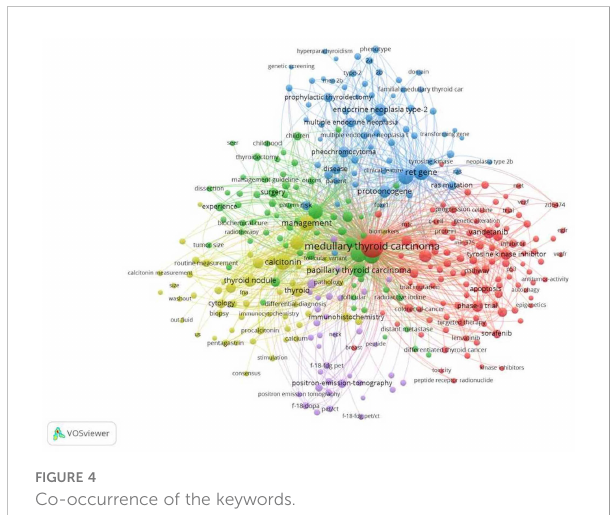
FIGURE 4 Co-occurrence of the keywords.